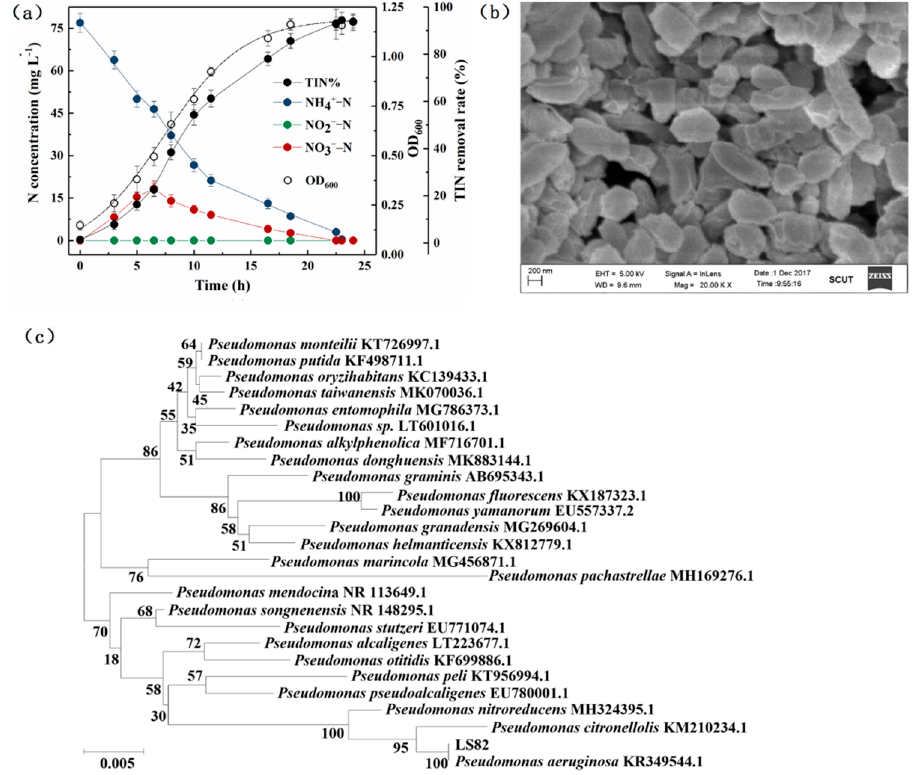
Figure 1. ( a ) Performance in terms of nitrogen removal; ( b ) SEM image; ( c ) phylogenetic tree based on 16S rRNA sequence of strain LS82.